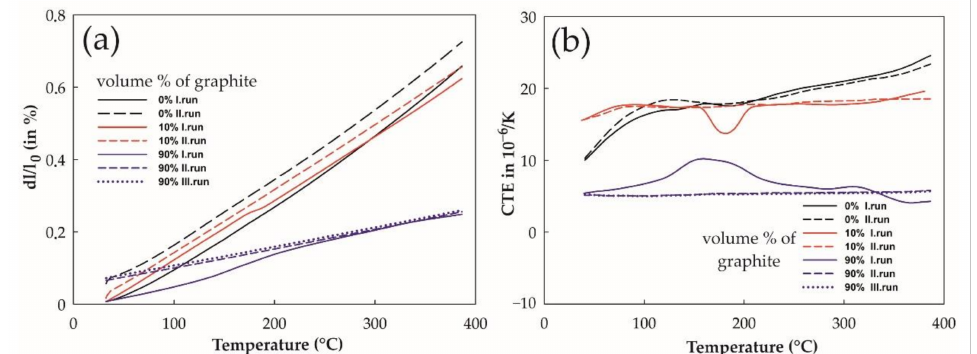
Figure 6. Dependence of relative elongation ( a ) and coefficient of thermal expansion ( b ) on tempera- ture for the Cu HIPed (black), Cu + 10% graphite (red), and Cu + 90% graphite (blue) samples. The first run (solid line), the second run (short dash line), and the third run (dotted line) are